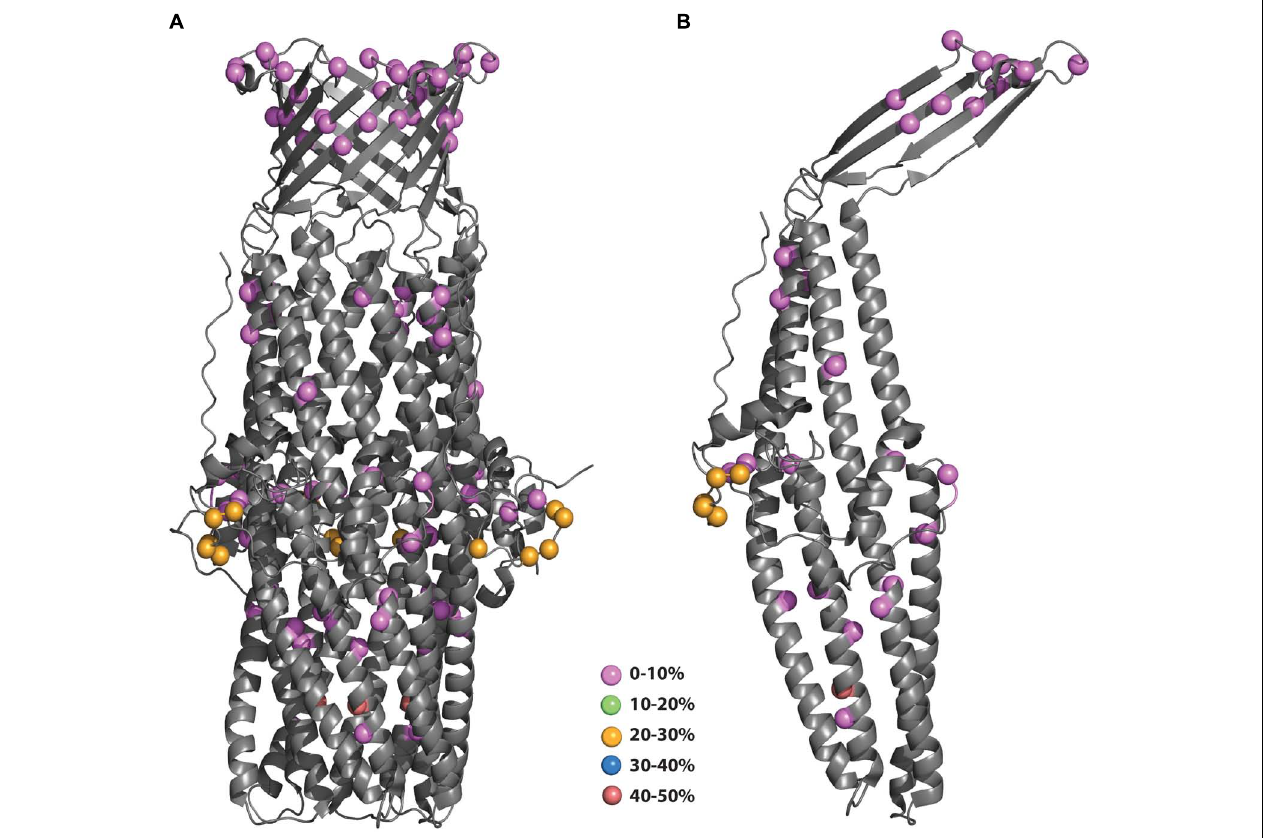
FIGURE 3 | (A,B) Polymorphisms of N. gonorrhoeae MtrE mapped onto the crystal structure. The polymorphisms from Figure 2A were mapped onto the structure of MtrE (4mt0) and colored according to their prevalence in the population. (B) Polymorphisms mapped to MtrE trimer